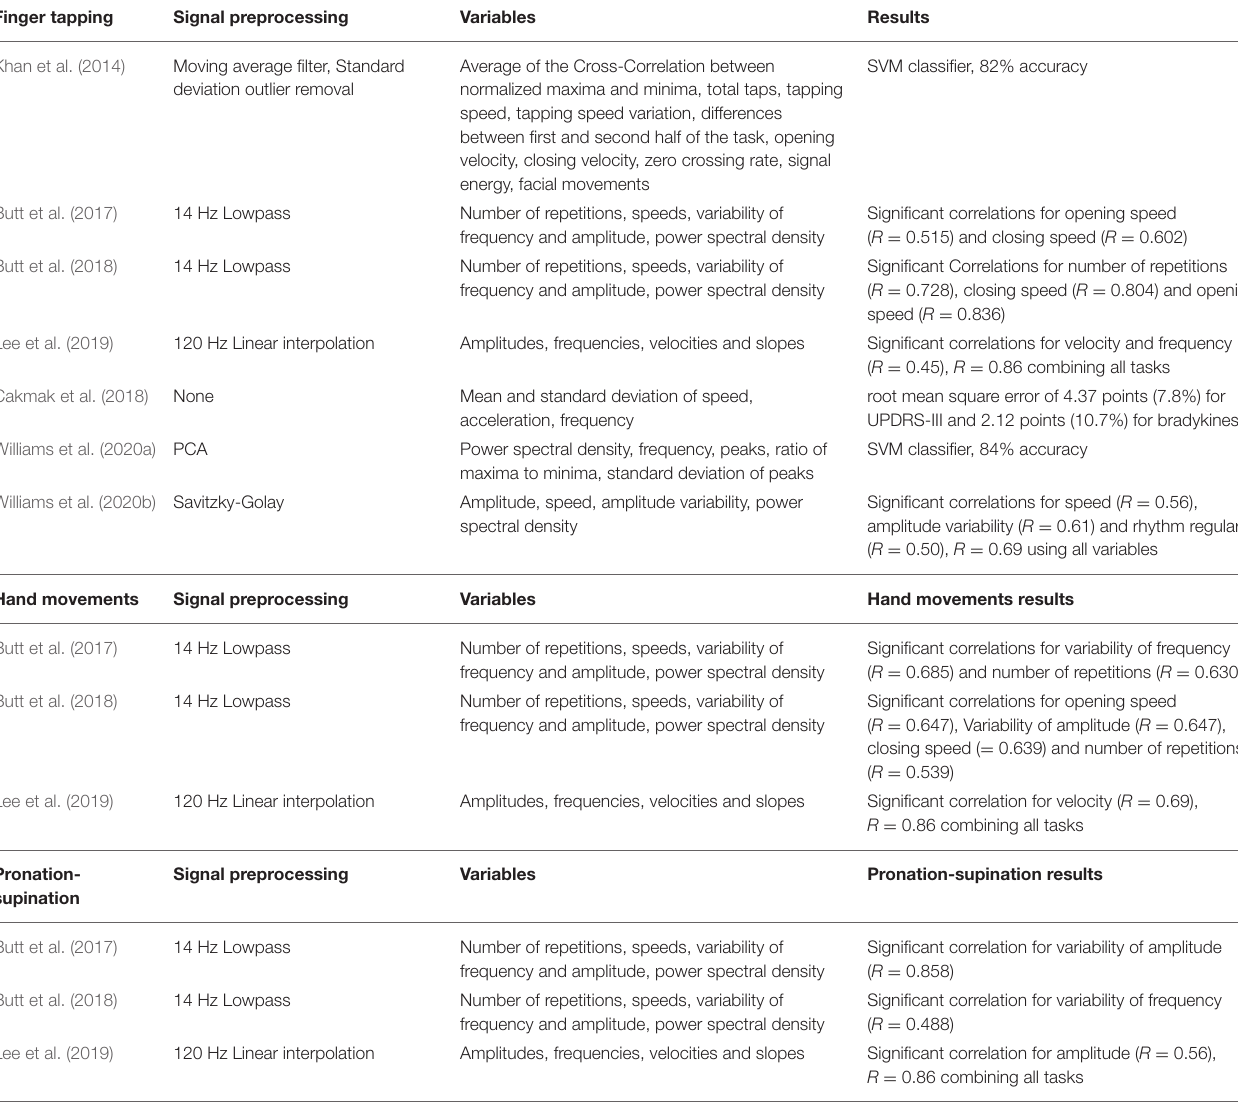
TABLE 4 | Classification results for